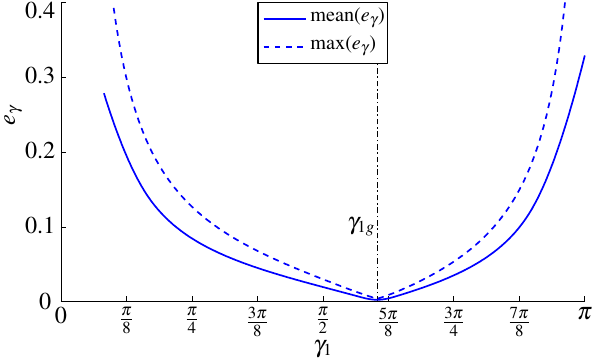
Figure 15. Mean and maximum error in the interval β 0 ≤ β ≤ β 2 as a function of γ 1 .